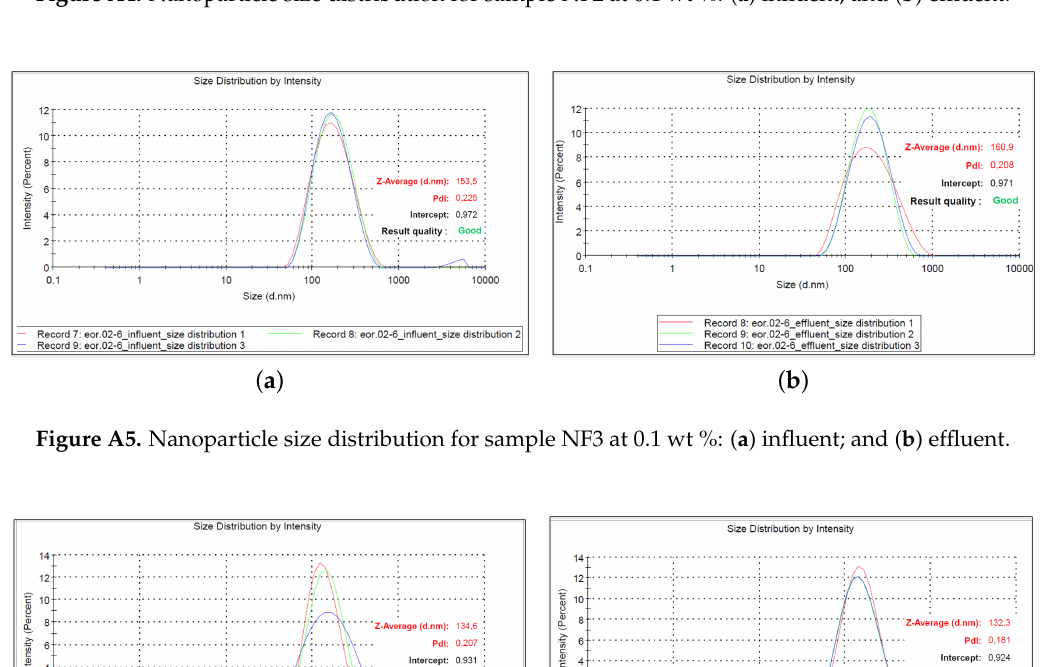
Figure A4. Nanoparticle size distribution for sample NF2 at 0.1 wt %: ( a ) influent; and ( b ) effluent.